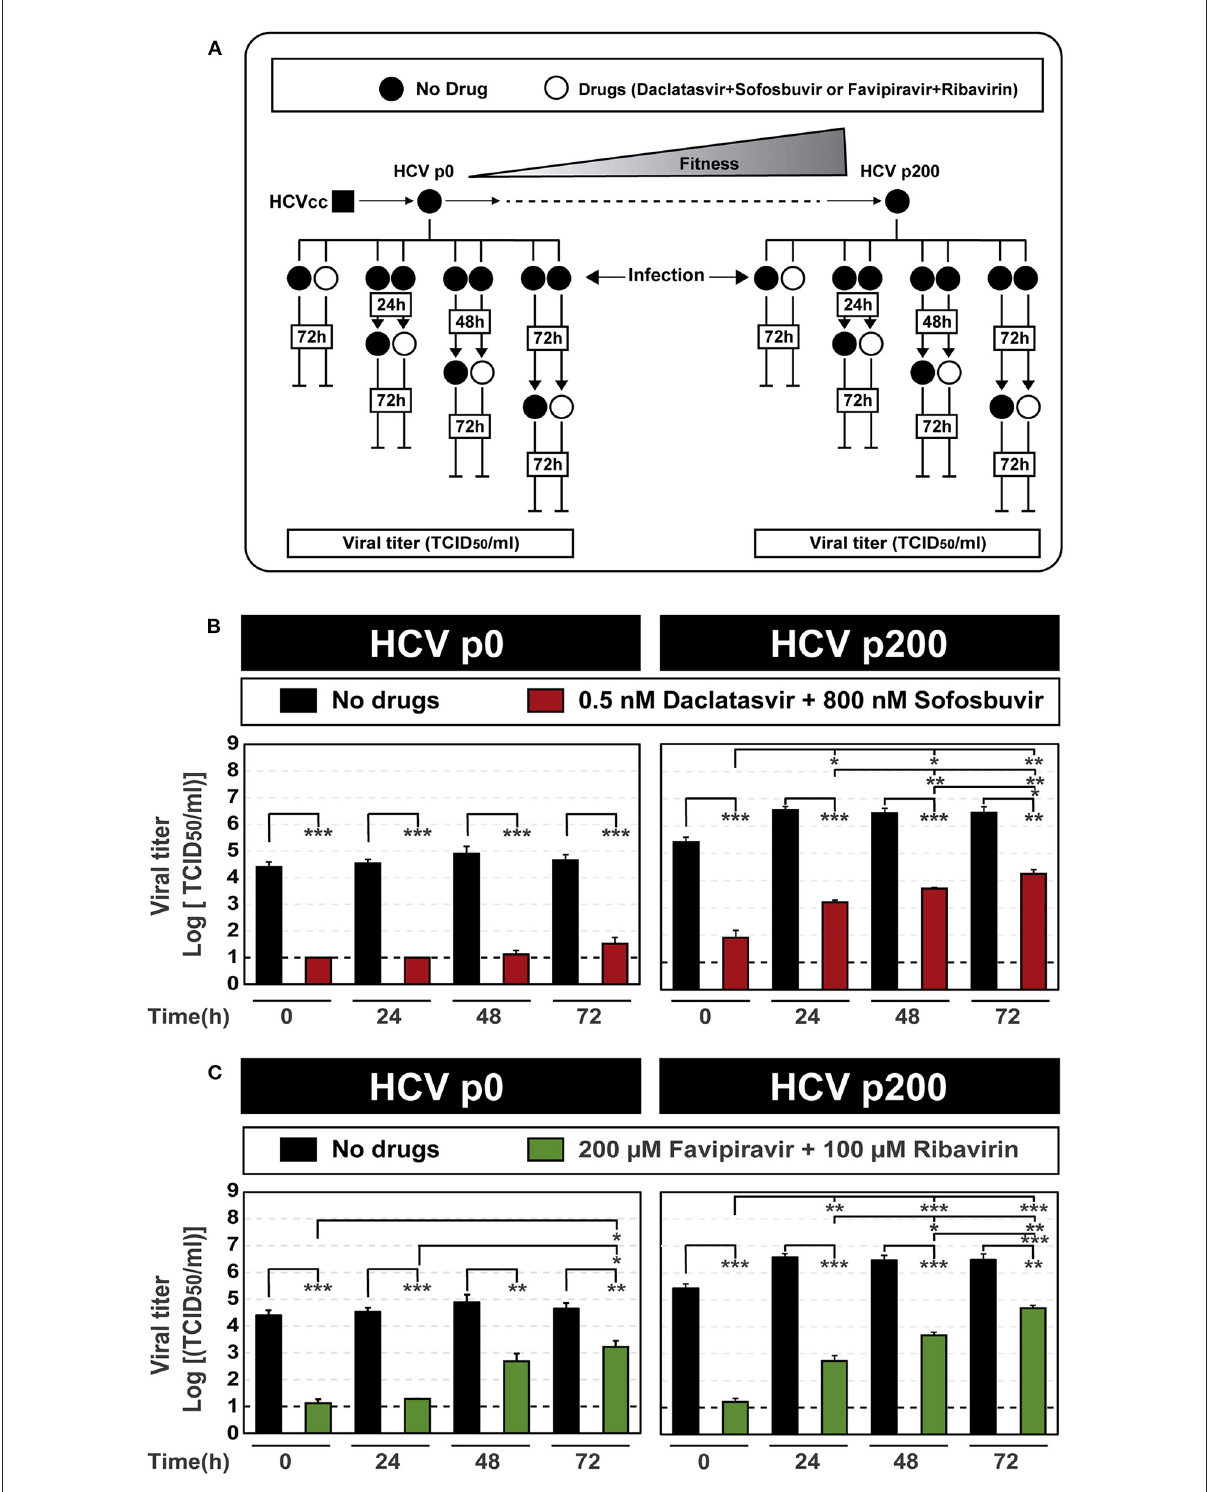
FIGURE1 Effect of the time of addition of inhibitor combinations after initiation of HCV infection. (A) Scheme of the experiment, displaying fitness gain upon subjecting HCV p0 [derived from HCVcc obtained by transfection of Lunet cells with RNA transcribed from plasmid Jc1FLAG2(p7-nsGluc2A)] to 200 serial passages in Huh-7.5 reporter cells to yield HCV p200. The time of infection and of addition of the inhibitors are indicated (empty boxes inserted in vertical lines); in all cases, cell culture supernatants were titrated for HCV infectivity at